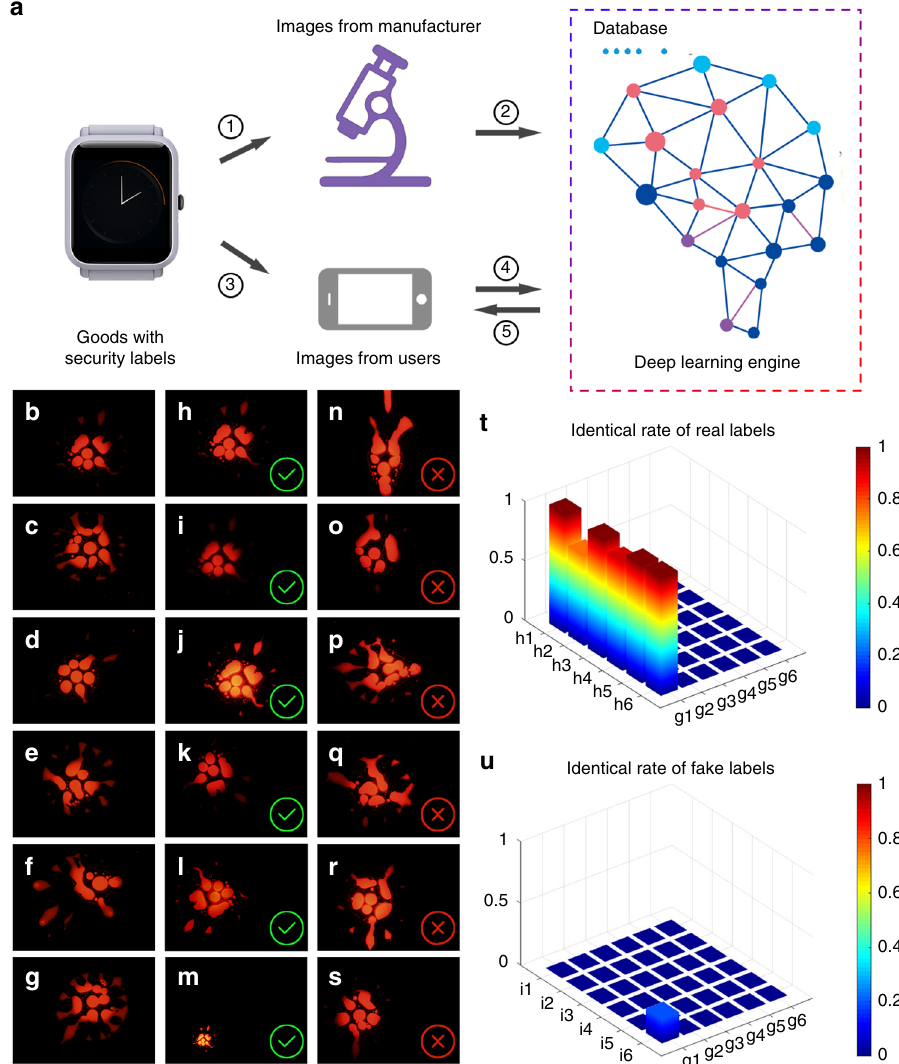
Fig. 4 Deep learning decoding mechanism. a Schematic illustrating the authentication process: 1: image capture and database generation from the goods by the manufacturers, 2: image learning by AI, 3: Image capture from the goods by the consumers using their smart phones, 4: image recognition and comparing by AI, and 5: authentication outcome feedback to the consumers. b – g A library of six single dot pattern security labels, h – m six fl uorescence images taken from b (referred as to genuine product) with different brightness, sharpness, rotation angles, magni fi cations, and the mixture of the above- mentioned factors, and n – s six fl uorescence images from security labels that are not in the database shown in panel b – g (referred as to fake products). t , u Recognition rates of labels (h1 – h6) and (i1 – i6) by the authenticating way of deep learning. Labels (g1 – g6), (h1 – h6), and (i1 – i6) correspond to the labels in fi gure ( b – g ), ( h – m ), and ( n – s ) respectively. The color scales from blue to red stand for the matching score (ranging from 0 to 100%) of the